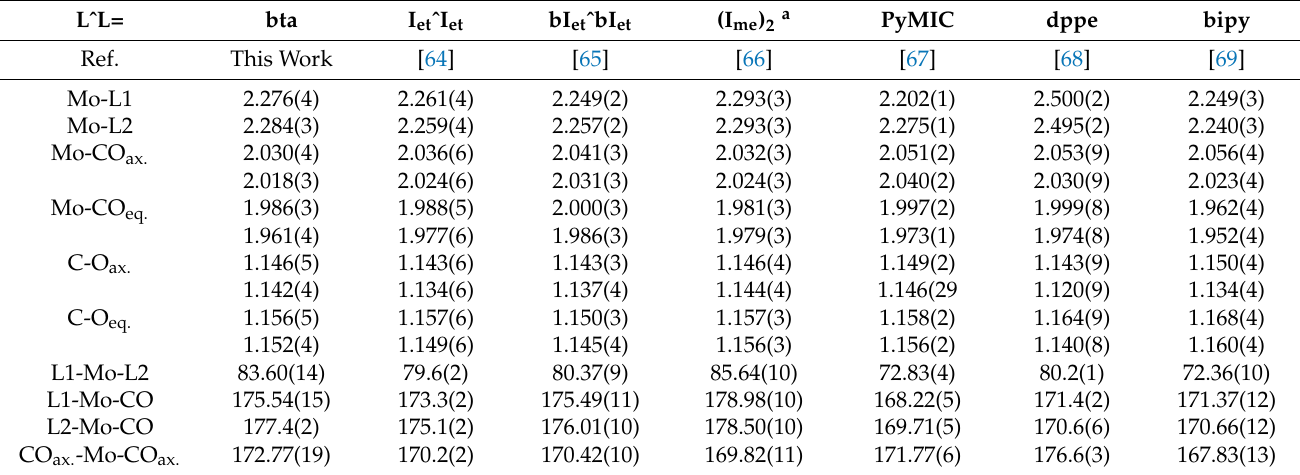
Table 2. Selected bond distances (Å) and angles ( ◦ ) of the bistriazolylidene coordinated complex ( 3 ) and selected examples for [Mo(CO) 4 (LˆL)] complexes from the